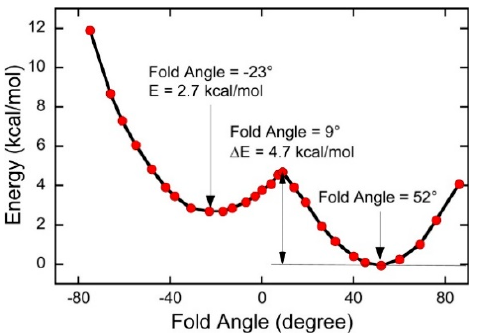
Figure 10. A double well in the ground state potential energy surface of Mo IV O(SPh) 2 ( i Pr 2 Dt 0 ) as a function of the ligand fold angle. (Adapted with permission from Inorganic Chemistry , 2016, 55, 785– 793. Copyright (2016) American Chemical